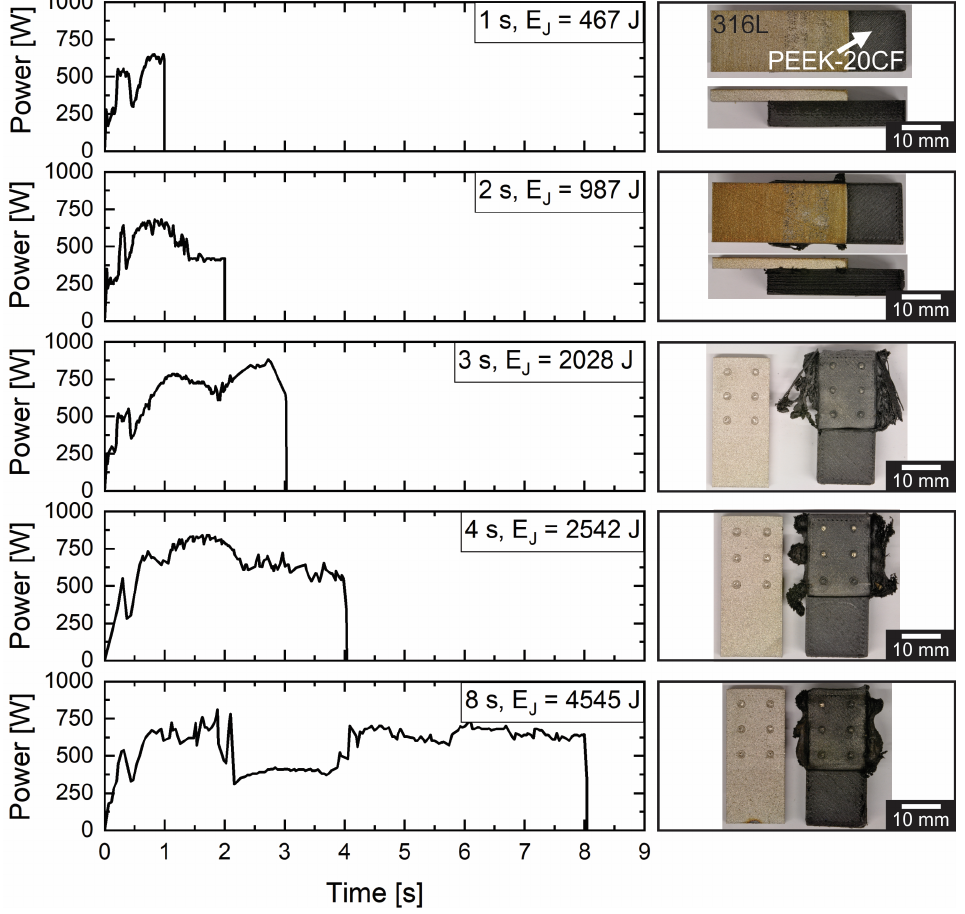
Figure 4. Comparison between energy input along joining cycles for different J T values: 1, 2, 3, 4 and 8 s and overview of their respective produced joints.